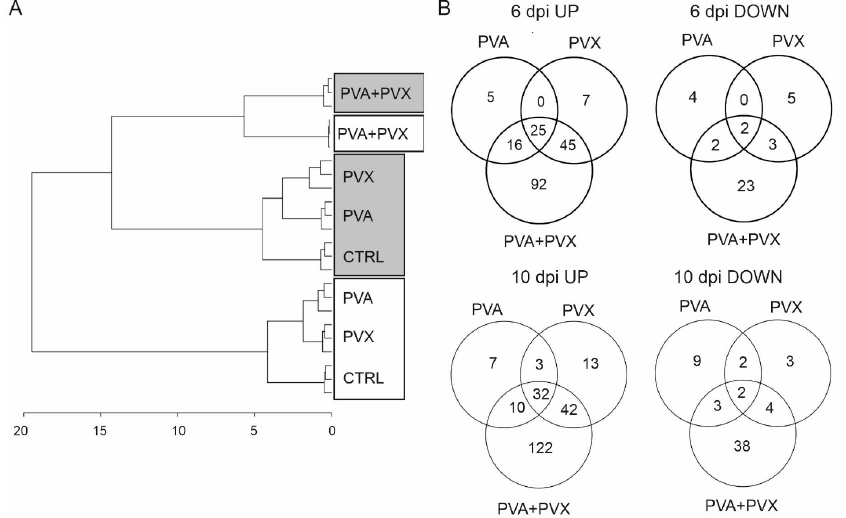
Figure 4. Metabolite analysis of single and mixed infections. ( A ) A dendrogram showing the differences between metabolite profiles in healthy controls and single and mixed PVA and PVX infections was generated based on hierarchical clustering analysis of the samples. 6 dpi local samples are boxed in gray and 10 dpi systemic samples are boxed in white. ( B ) Significantly up and down regulated metabolites in the infections at 6 and 10 dpi. Venn diagrams represent the numbers unique and shared metabolites in single and mixed infections compared to the control samples.